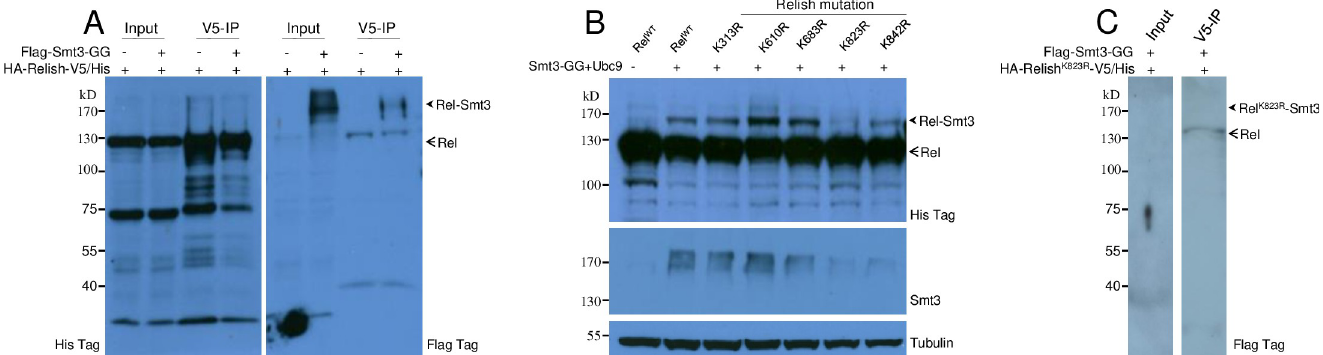
Fig 4. SUMOylation of Relish. (A) Relish can be SUMOylated. Wild type Relish (HA-Rel WT -V5/His) was expressed alone or co-expressed with Flag-Smt3-GG in S2 cells. Antibody against the V5-tag was applied for IP and enrichment. The arrowhead points to SUMOylated Relish (labeled Rel-Smt3); the arrow points to the position of Relish. (B) Identification of the main SUMOylation amino acid in Relish. The potential SUMOylation sites (lysine) were predicted online (http://sumosp. biocuckoo.org). Each lysine was mutated into arginine respectively. Rel WT and each Relish mutant as indicated were co-expressed with Smt3-GG and Ubc9. The arrowhead points to the SUMOylated Relish (Rel-Smt3); the arrow indicates Relish proteins. Polyclonal antiserum against Smt3 was also applied to show the SUMOylated proteins. (C) The supposed Rel K823R -Smt3 cannot be enriched after IP. HA-Rel K823R -V5/His was co-expressed with Flag-Smt3-GG in S2 cells for IP and enrichment. The supposed Rel K823R -Smt3 was indicated based on molecular weight